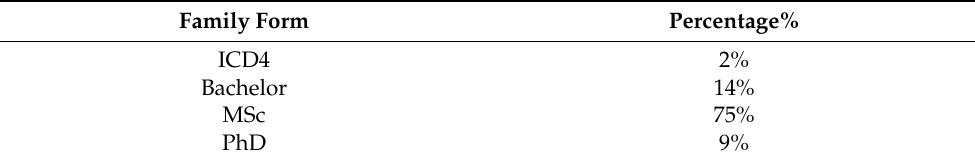
Table 5. Educational level.